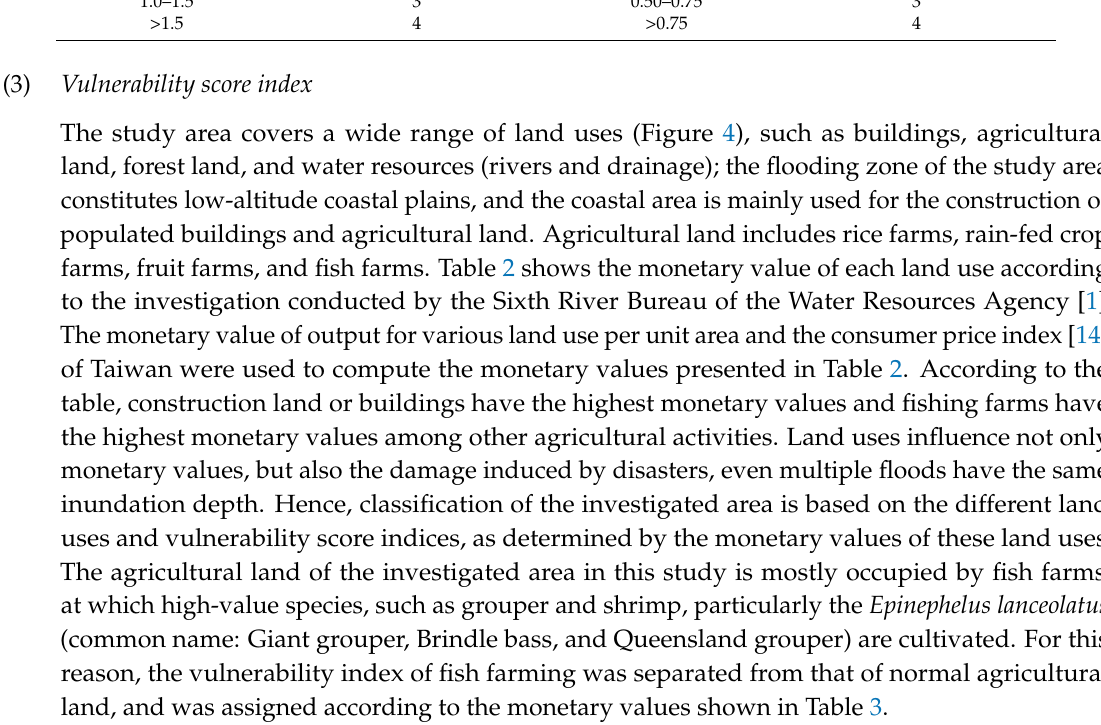
Table 1. Inundation depth and inundation duration index.